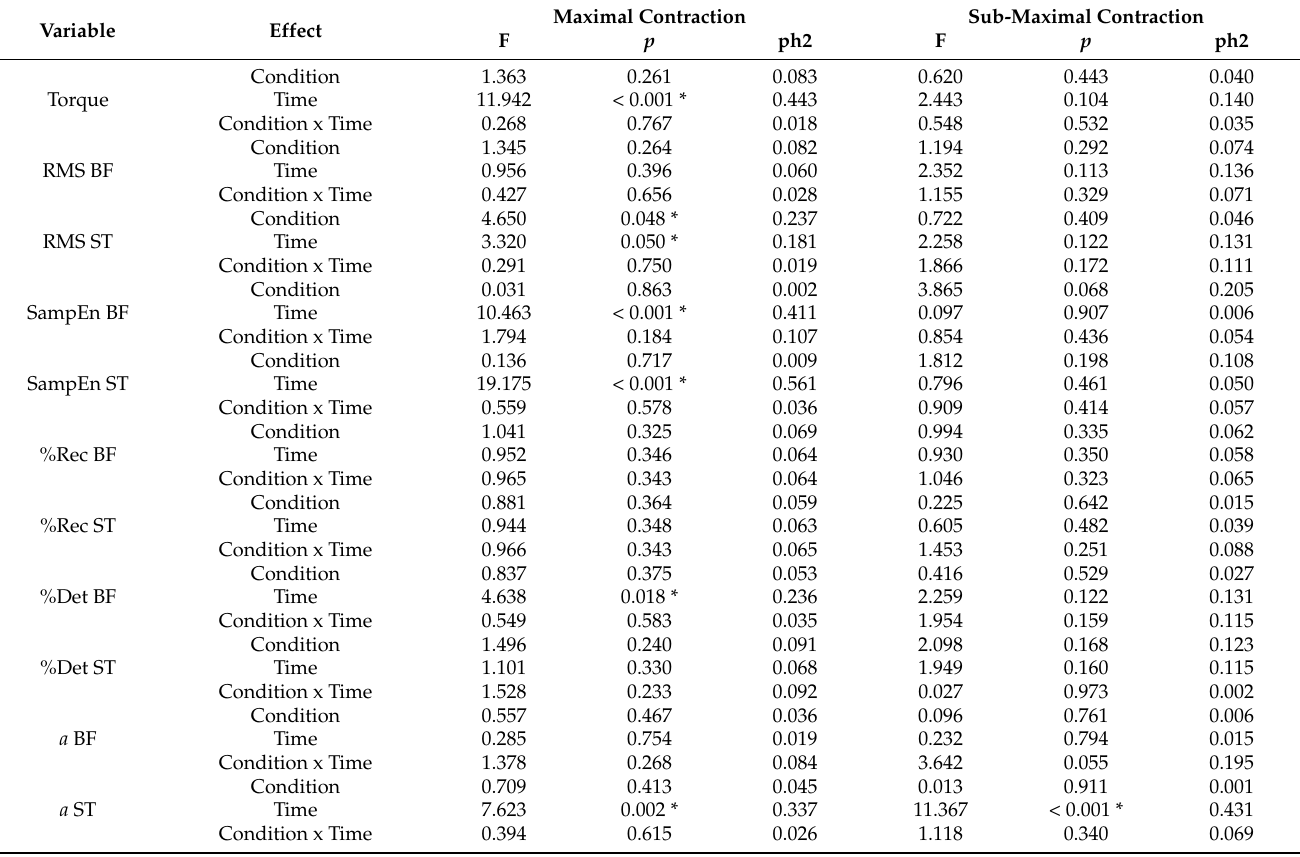
Table 1. Results of the two-way repeated measures